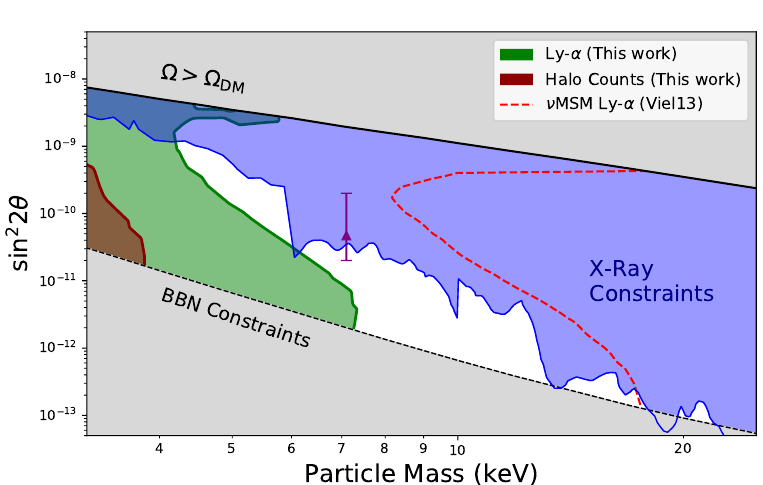
Figure 16. Parameter space constraints for ν MSM, where MW satellite halo counts and Lyman- α forest bounds are analyzed under a self-interacting model as outlined above. For each point ( θ , m ) in the parameter space, we consider a self-interacting model under a vector field mediator, with its interaction constant given by σ / m ∼ 0.144 C 2 v / m 3 = 0.1 cm 2 g − 1 , the upper limit given by bullet cluster constraints (see [87] for details). For comparison, we plot the Lyman-alpha bounds for the non-interacting case for a comparable analysis, plus other bounds to the ν MSM parameter space for informative purposes, namely X-ray indirect detection bounds (in blue) and sterile neutrino production bounds (in grey). We also plot the sterile neutrino model compatible with a tentative 3.5 keV DM signal, a subject of debate in recent years, as a purple triangle. The complete list of references for all such bounds can be found in [87]. Reprinted from [87], Copyright IOP Publishing, with permission.